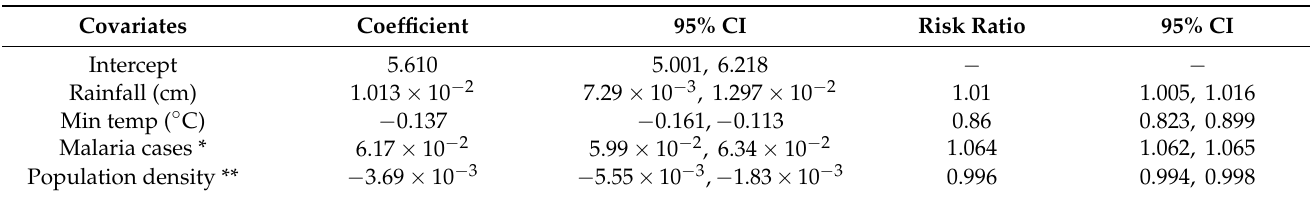
Table 2. Associations between environmental variables and malaria incidence risk in the Greater Accra Region,